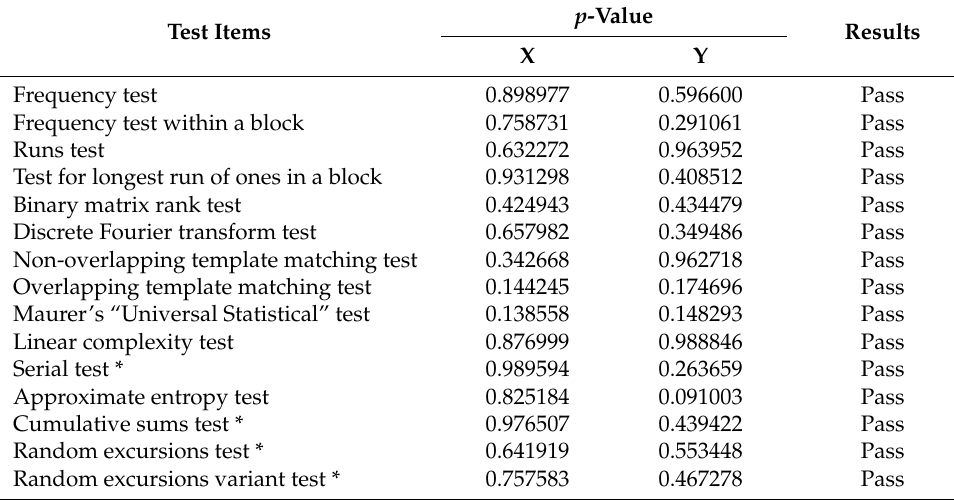
Table 1. NIST SP800-22 test.